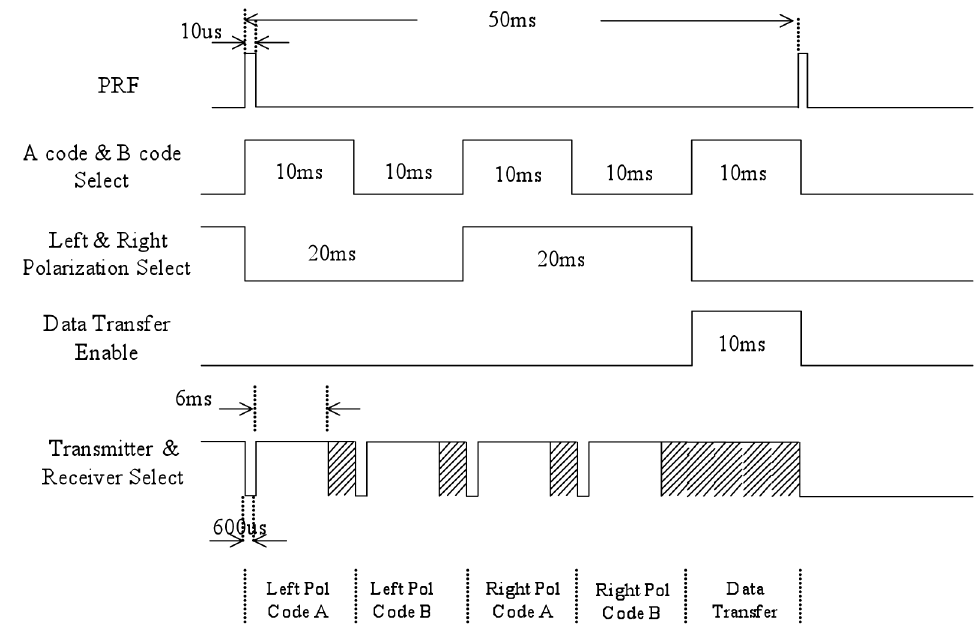
Figure 2. The timing for separating O wave and X wave in CAS-DIS.